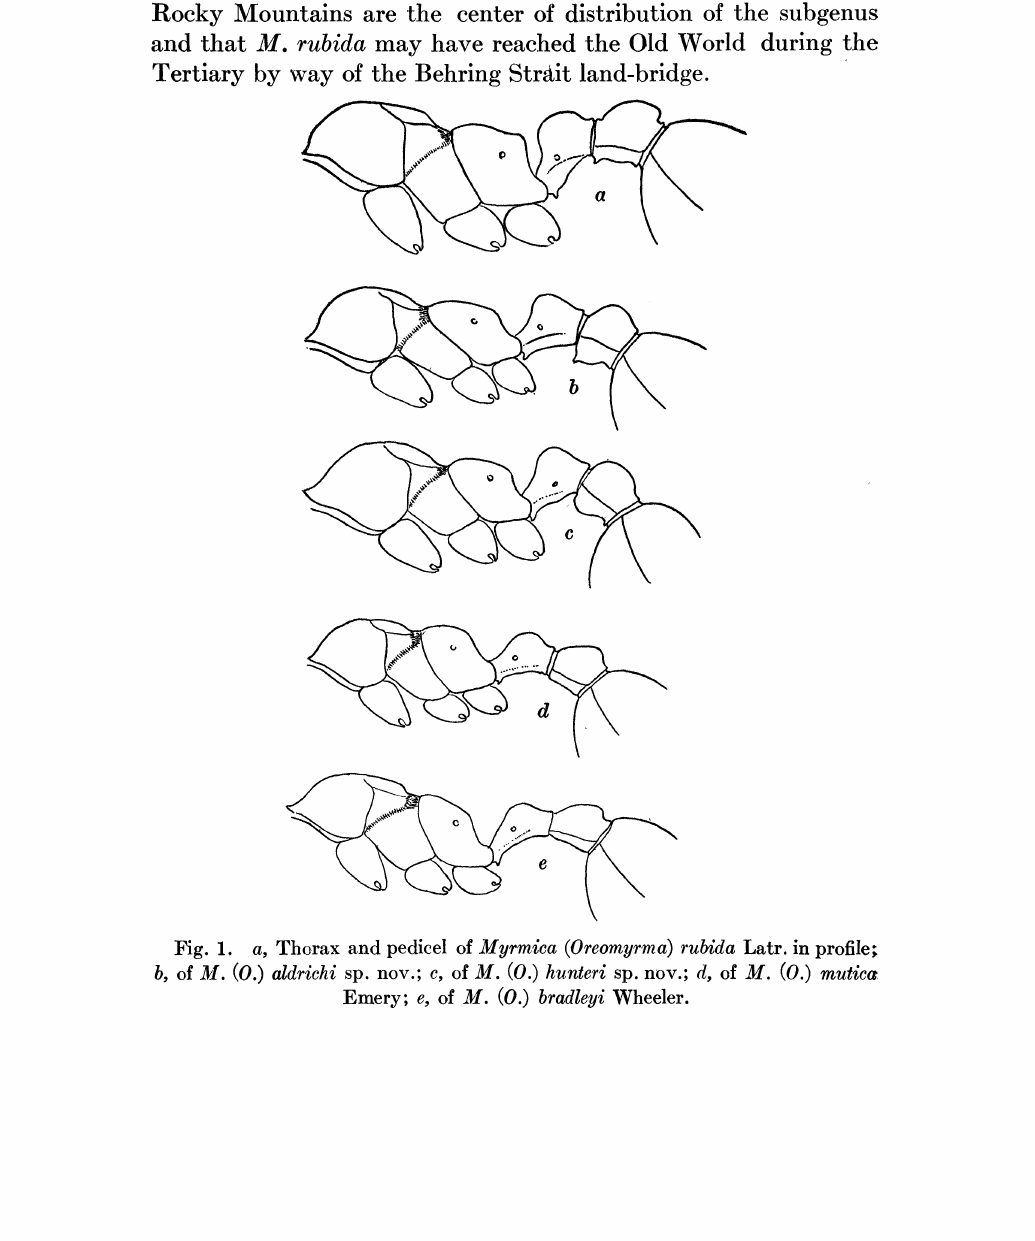
Fig. 1. a, Thorax and pedicel of Myrmica (Oreomyrma) rubida Latr. in profile; b, of M. (0.) aldrichi sp. nov.; c, of M. (0.) hunteri sp. nov.; d, of M. (0.) mutica Emery; e, of M. (0.) bradleyi